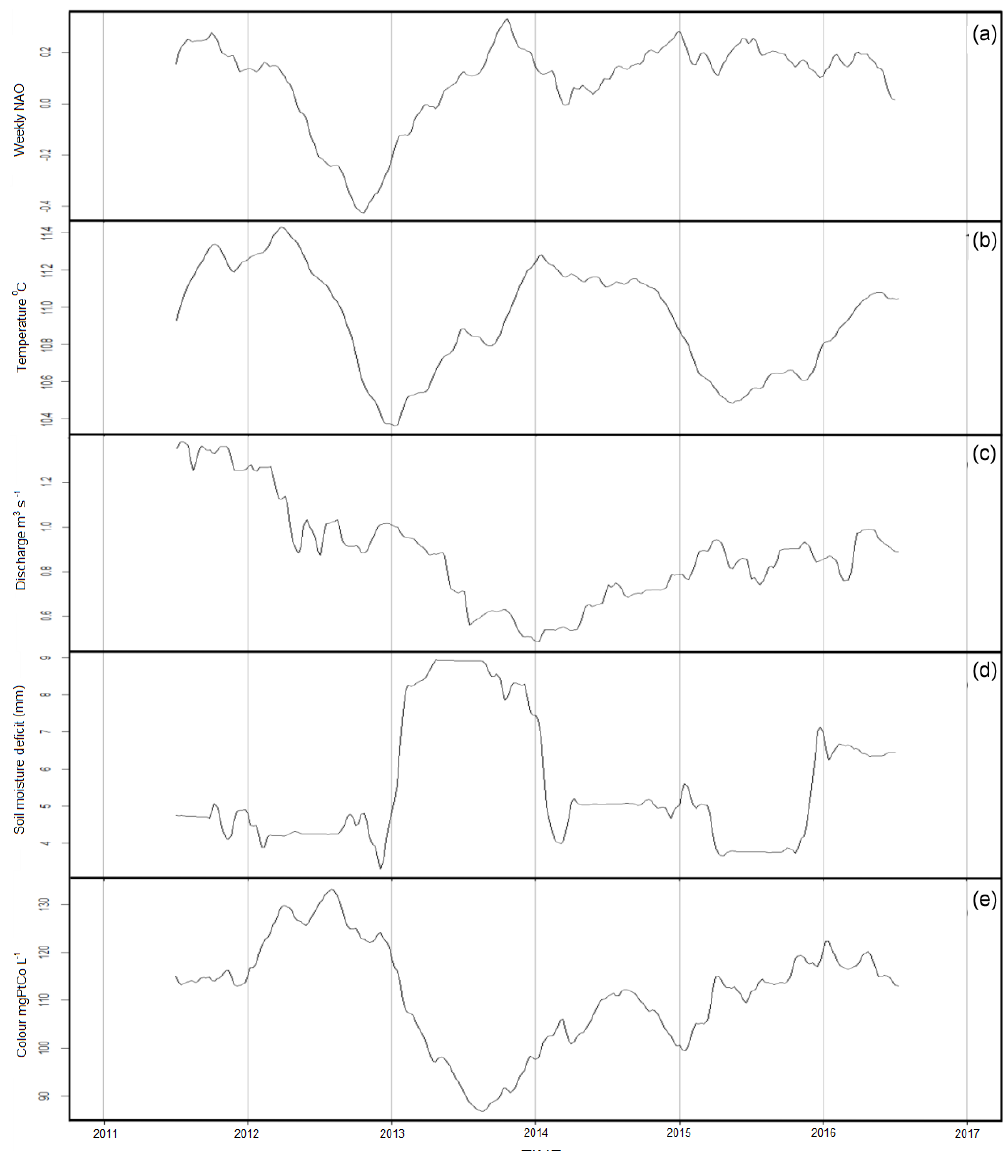
Figure 5. (a) Trend of weekly NAO during the study period, (b) trend of weekly soil temperature, (c) trend of weekly discharge in the Glenamong River, (d) trend of weekly soil moisture deficit (SMD) and (e) trend of mean weekly mean colour concentration in the three sub-catchment